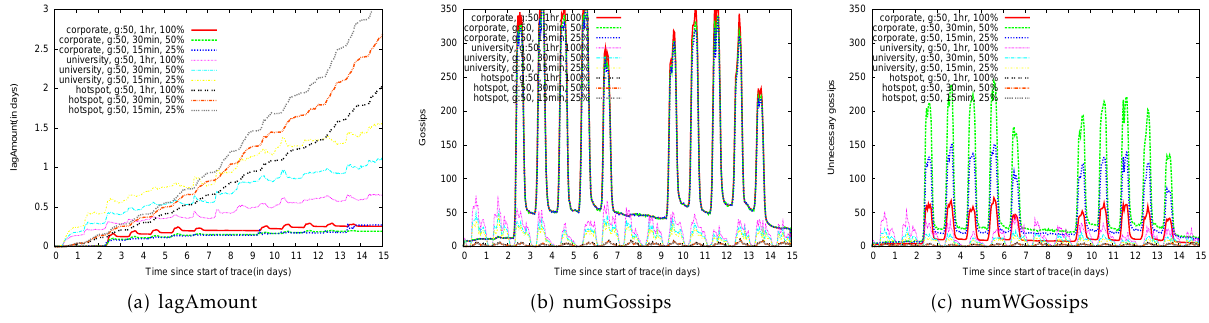
Figure 18. Tradeoff between update frequency and choosing fewer online nodes (group size: 50, P2P-pull